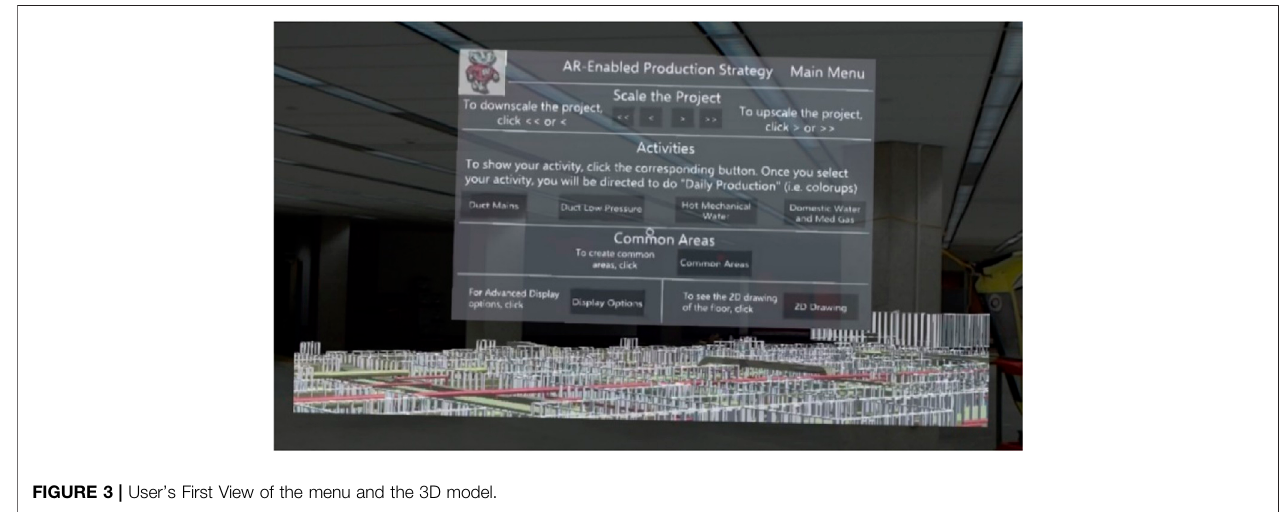
FIGURE 3 | User ’ s First View of the menu and the 3D model.